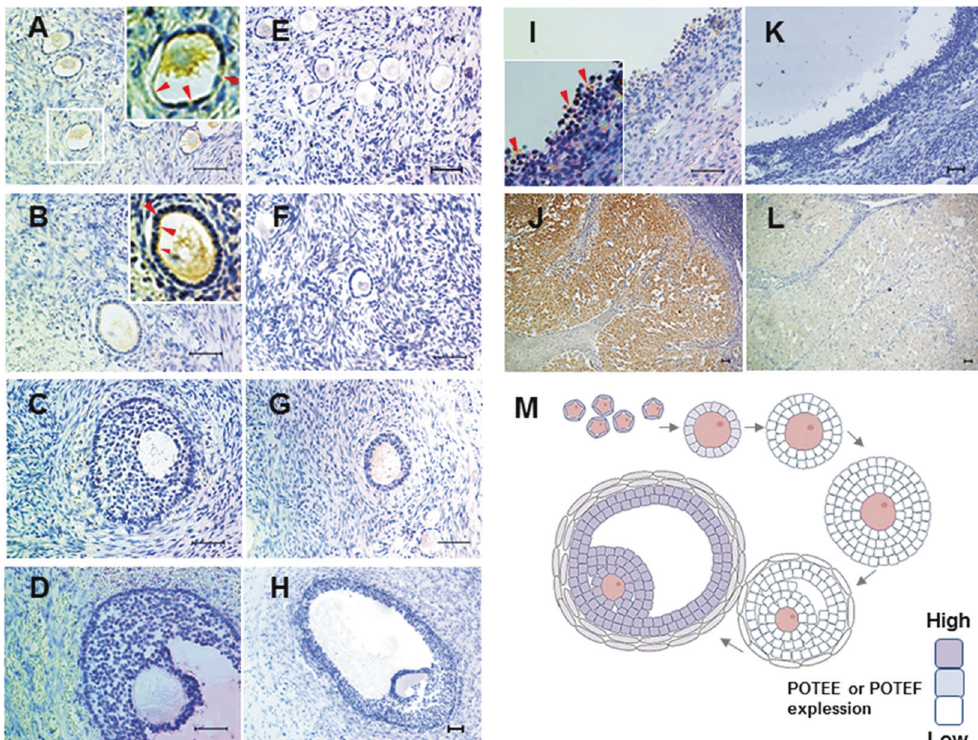
Fig. 1 Localization of POTEE or POTEF protein during human folliculogenesis. Representative IHC images of POTEE or POTEF staining in serially sectioned human normal ovarian tissue. A Primordial follicle. B Primary follicle. C Secondary follicle. D Small antral follicle. I Large antral follicle. J Corpus luteum. E – H , K , L IHC images with rabbit IgG was used as a negative control. Scale bars, 50 µm. M Illustration of changes in POTEE or POTEF protein expression during follicle development. Red arrowheads indicate POTEE or POTEF staining in granulosa